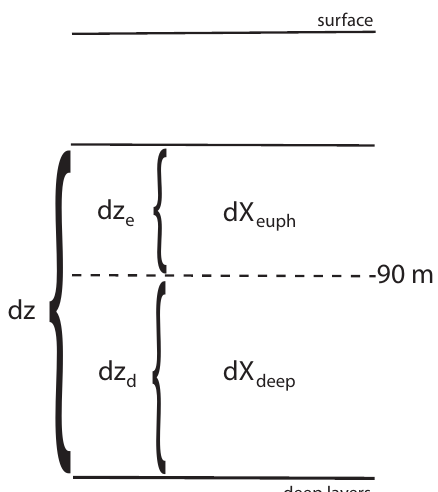
Fig. 1. Schematic diagram illustrating the virtual split of the model layer containing the 90m deep lower boundary of the euphotic zone. Please note that this 90m boundary may lie either within the mixed layer or below the mixed layer and a number of thin or massless layers, not necessarily in the second layer below the surface.